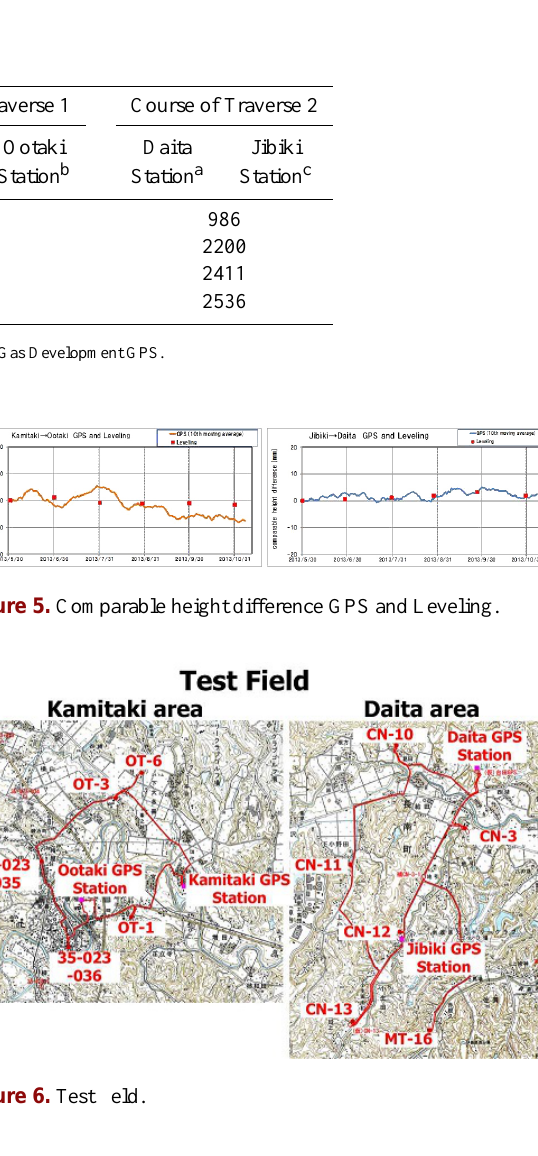
Figure 4. Course of traverse.